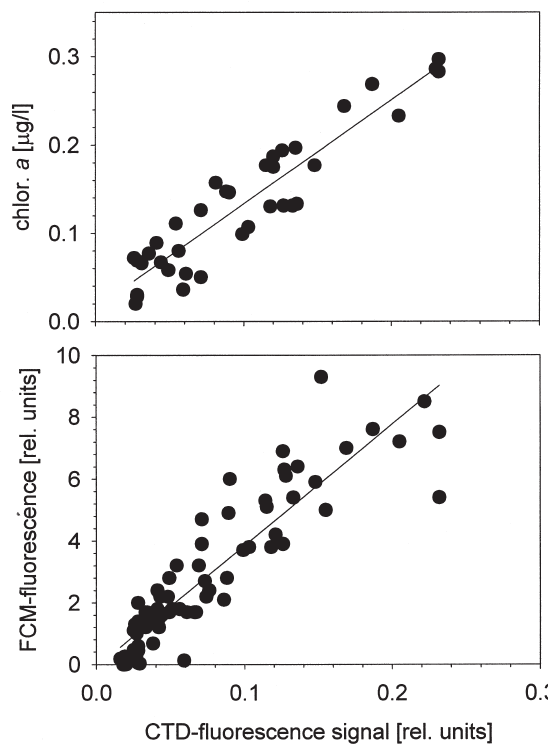
(upper panel) and versus DNA content (120 algal strains, lower panel) (modified after Veldhuis et al. ,